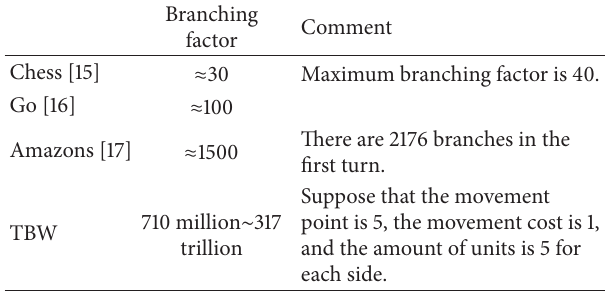
Table 1: Branching factors comparison between TBW game and other board